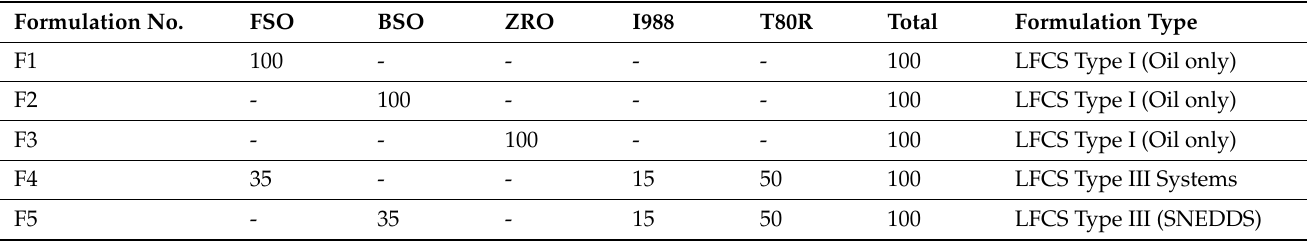
Table 9. Bioactive lipid excipients and their combinations in the developed formulations as per lipid formulation classification systems